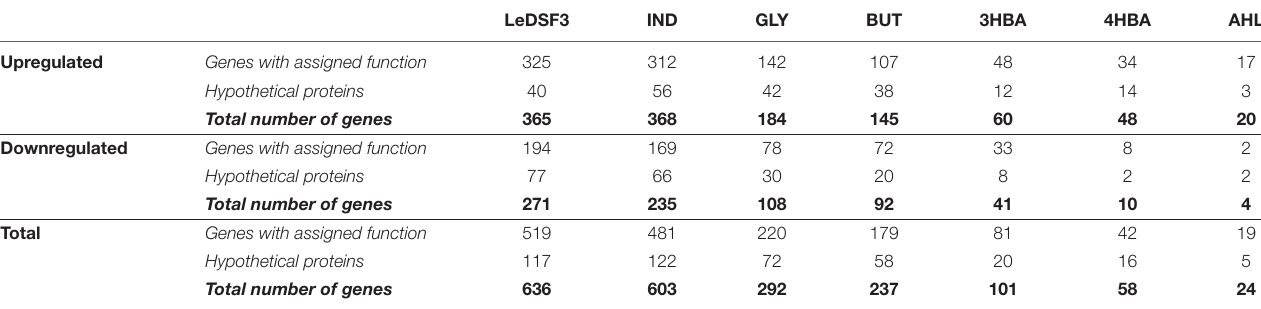
TABLE 2 | Differentially expressed genes in Lysobacter capsici AZ78 in response to diffusible communication signals after 48-h